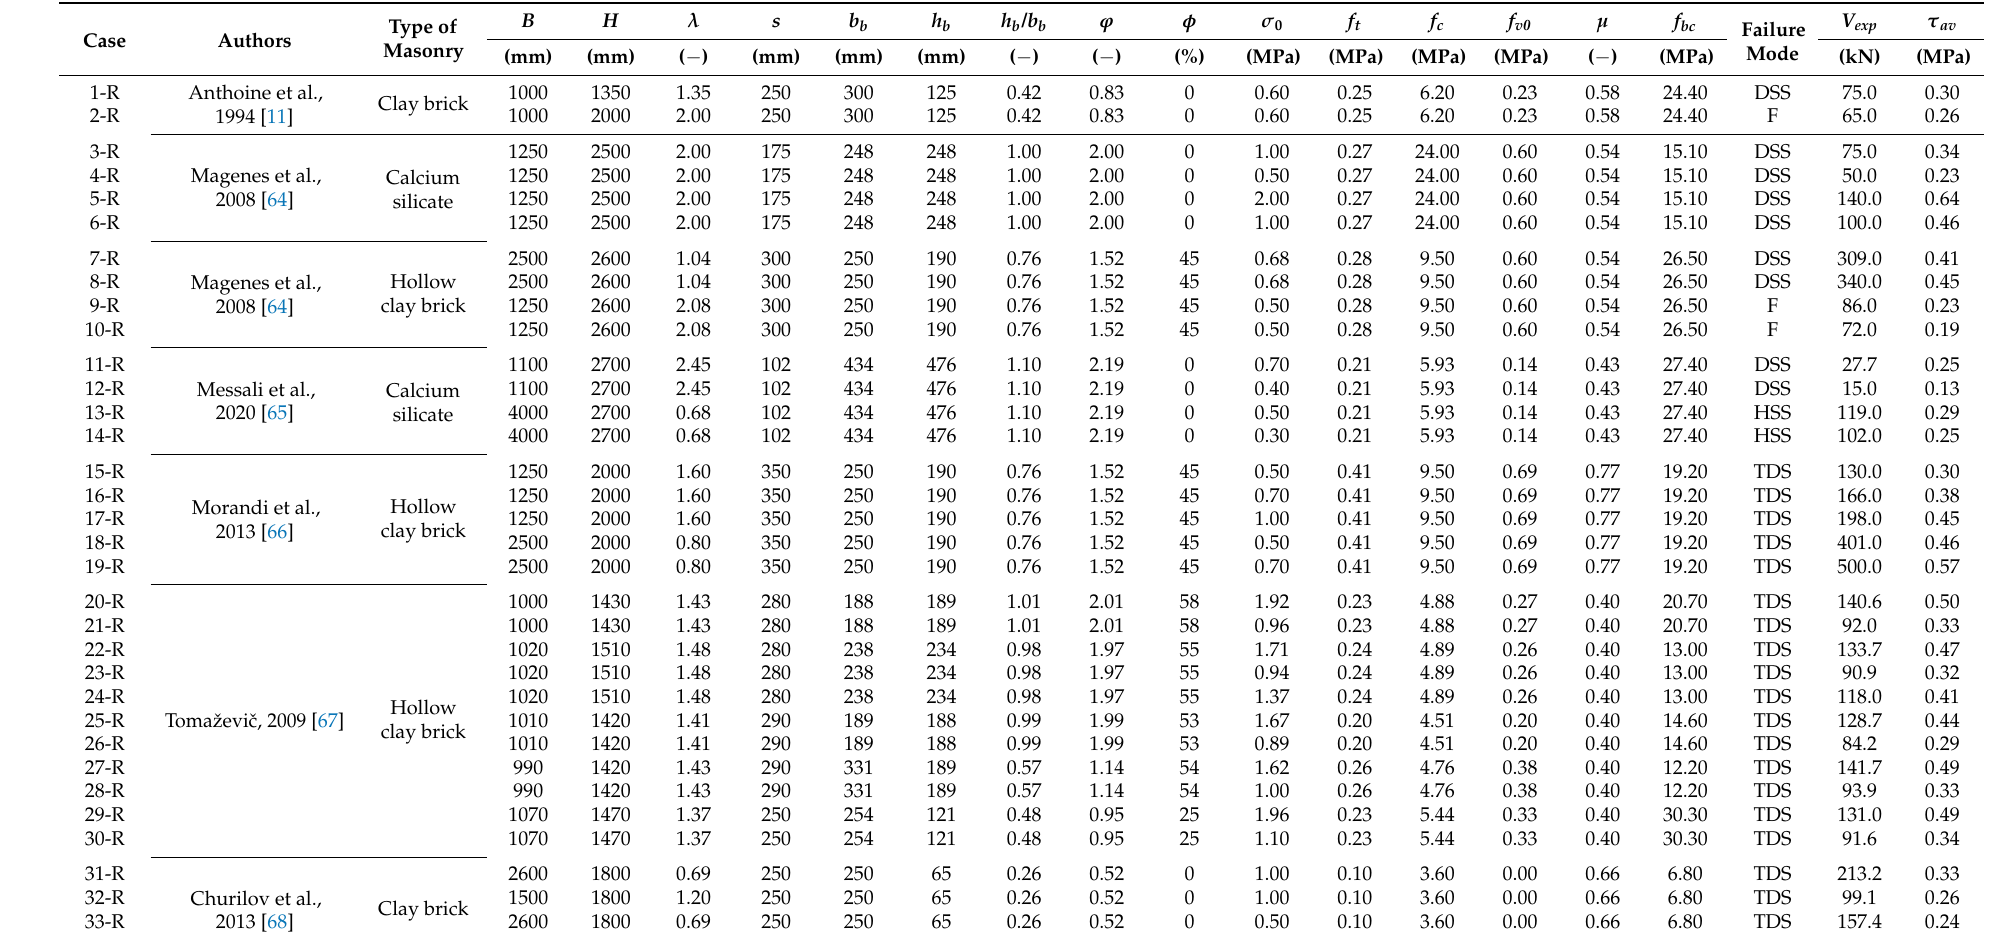
Table 5. Database of experimental tests on regular masonry